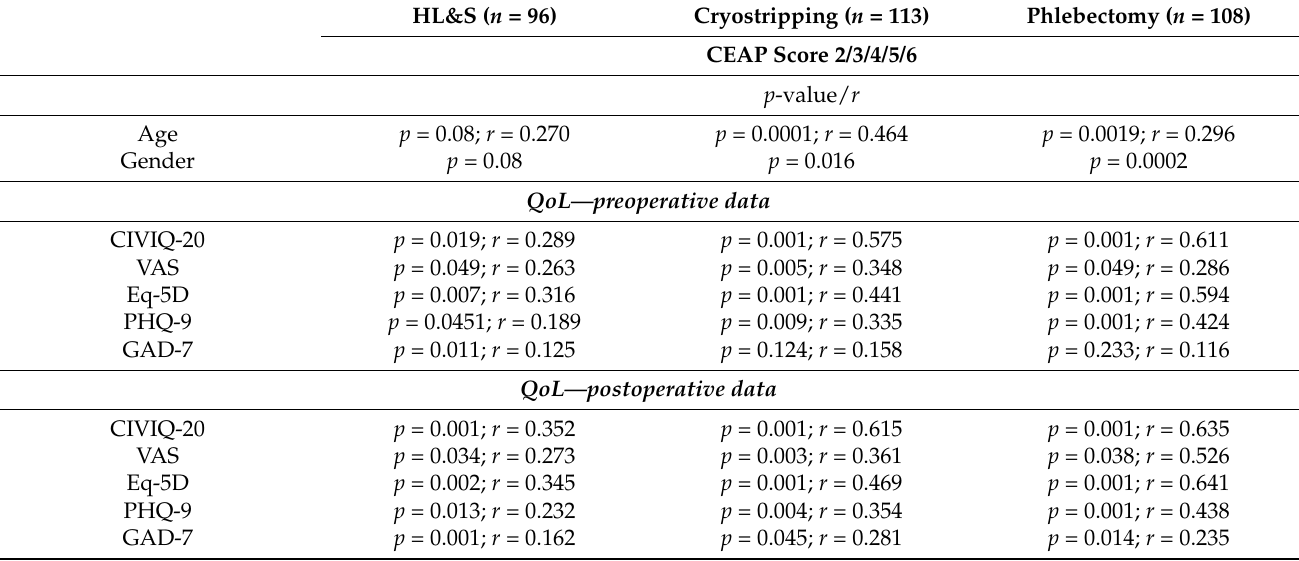
Table 2. Preoperative and postoperative data.